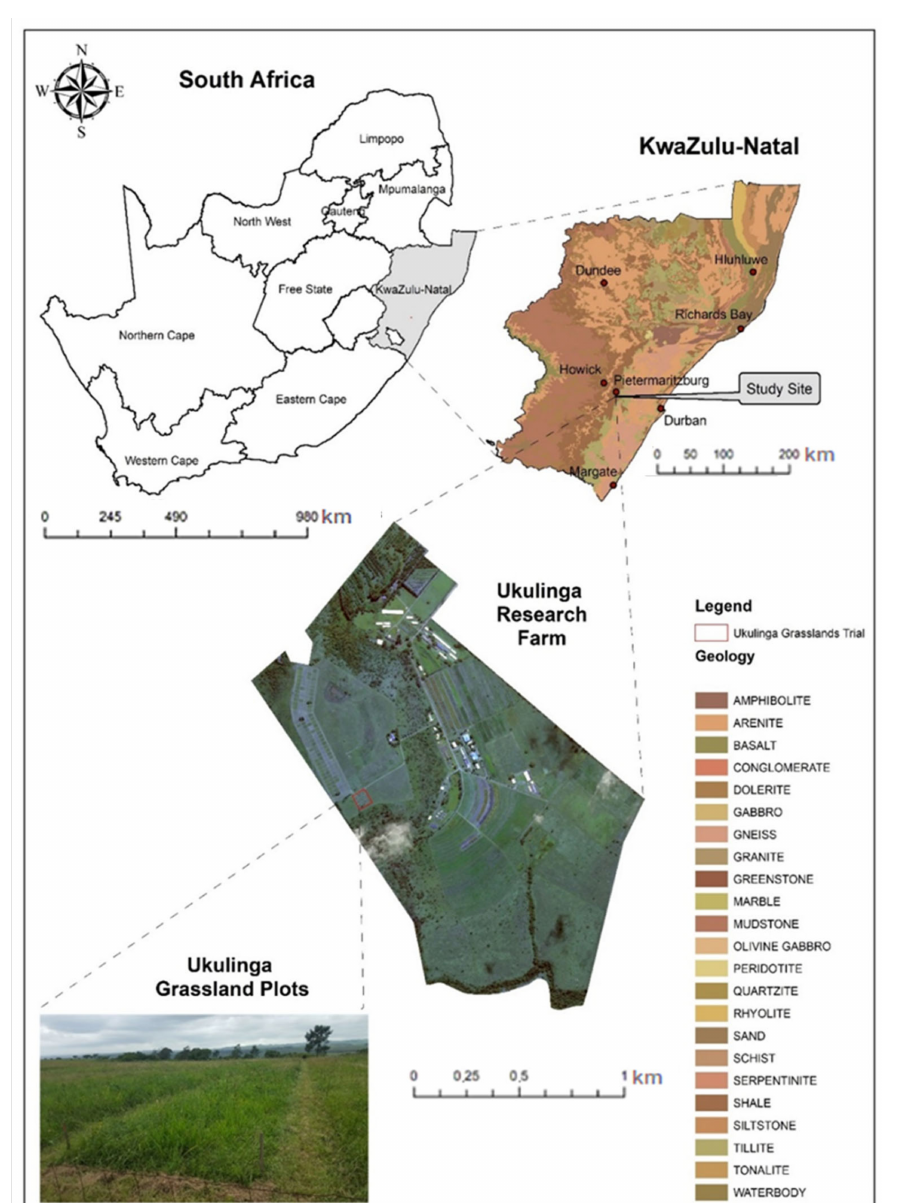
Figure 1. Location of the study area within the Ukulinga research farm, near Pietermaritzburg, South